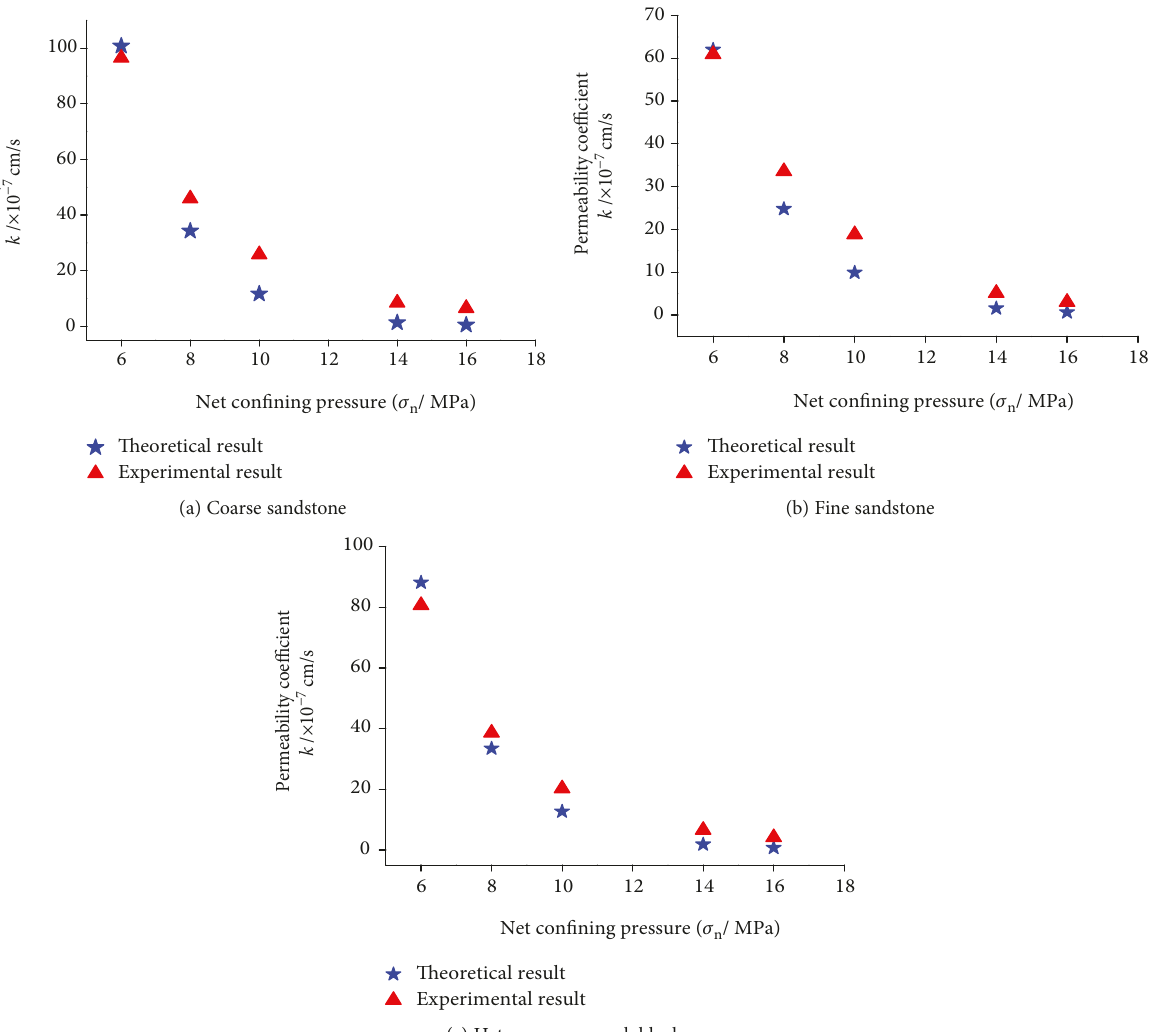
Figure 12: Comparison of calculated values and experimental values of permeability coe ffi